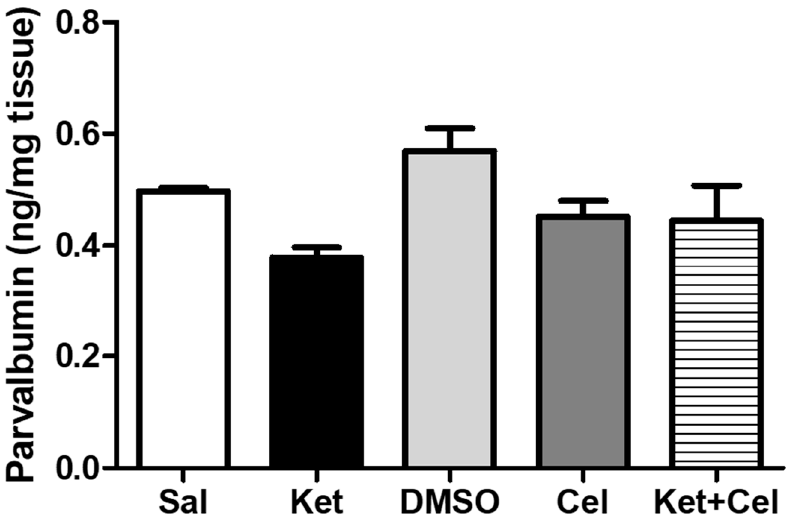
Figure 7. PV levels were not altered in the cerebellum of adult mice exposed to ketamine in postnatal life. PV levels (ng/mg tissue) in the cerebellum of adult mice receiving saline (Sal, n = 3) or ketamine (Ket, n = 5) or a 50% DMSO in PBS (DMSO, n = 3) or celastrol (Cel, n = 3) or ketamine + celastrol (Ket + Cel, n = 5) at PNDs 7, 9 and 11. One Way ANOVA, followed by Tukey’s post hoc test F = 2.632, p > 0.05 for all comparisons.